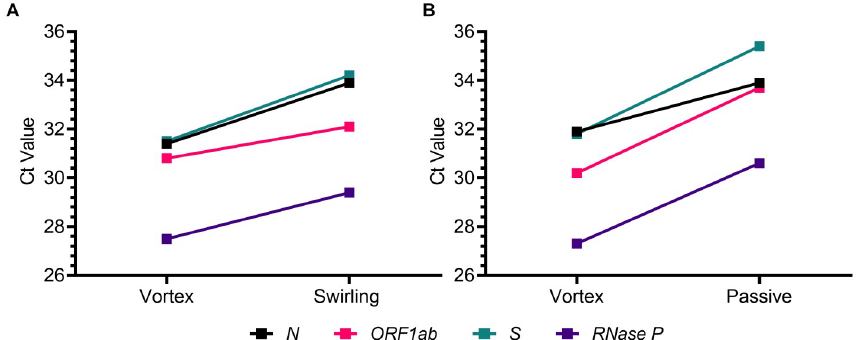
Fig 2. Dry swab elution by vortex is superior to swab swirling and passive release. Elution by vortex was compared to swab swirling (A) and passive release (B). Mean Ct values for the SARS-CoV-2 targets and RNase P are shown from paired polyester swabs collected from human volunteers (n = 5) and spiked with the low-positive hot pool (2x LoD; 20 GCE/PCR reaction). Ct values for swab swirling and passive release were all statistically higher (p < 0.05) than Ct values from paired vortexed